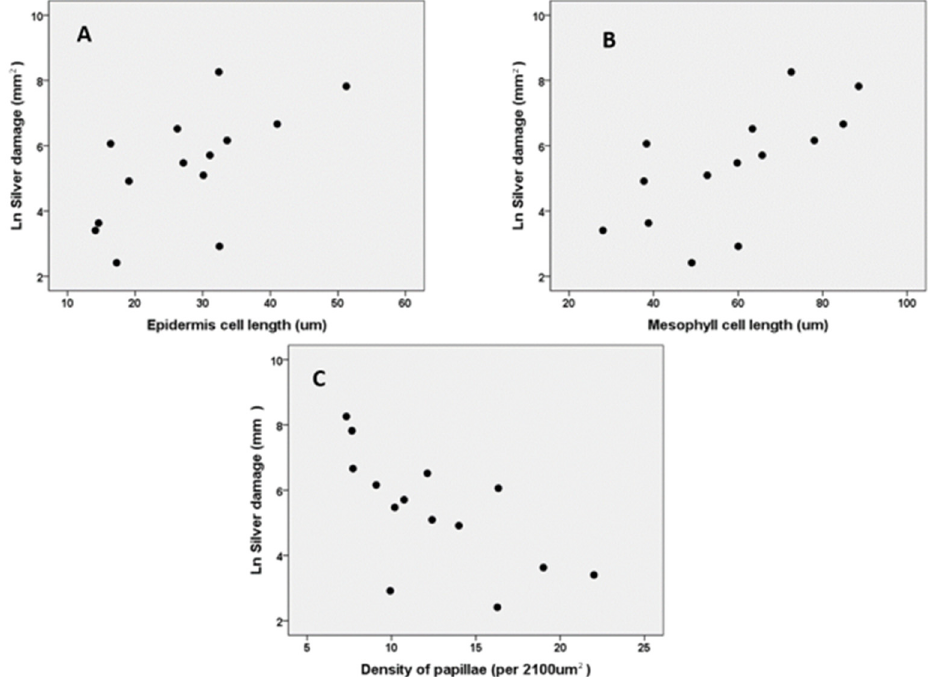
Figure 5. Correlation between thrips silver damage, measured in a whole-plant non-choice bioas-say, and cell length of epidermal cells ( A ) ( r = 0.596, N = 14, p = 0.024) and mesophylls ( B ) ( r = 0.603, N = 14, p = 0.022) and density of epidermal papillae ( C ) ( r = − 0.628, N = 14, p = 0.016) in 14 Gladiolus varieties.